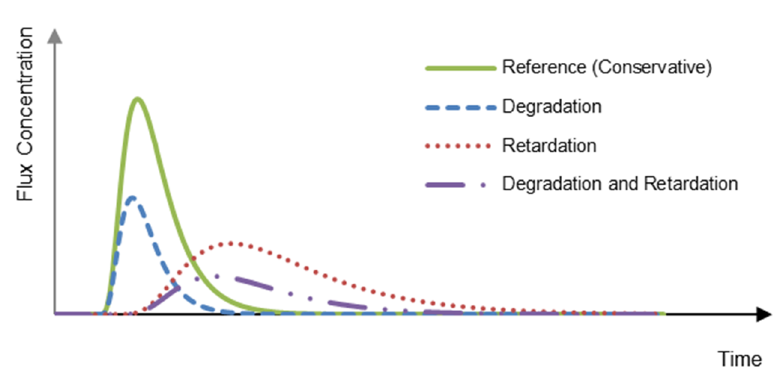
Figure 1. Schematic breakthrough curves for conservative tracer and reactive tracers after a pulse injection.